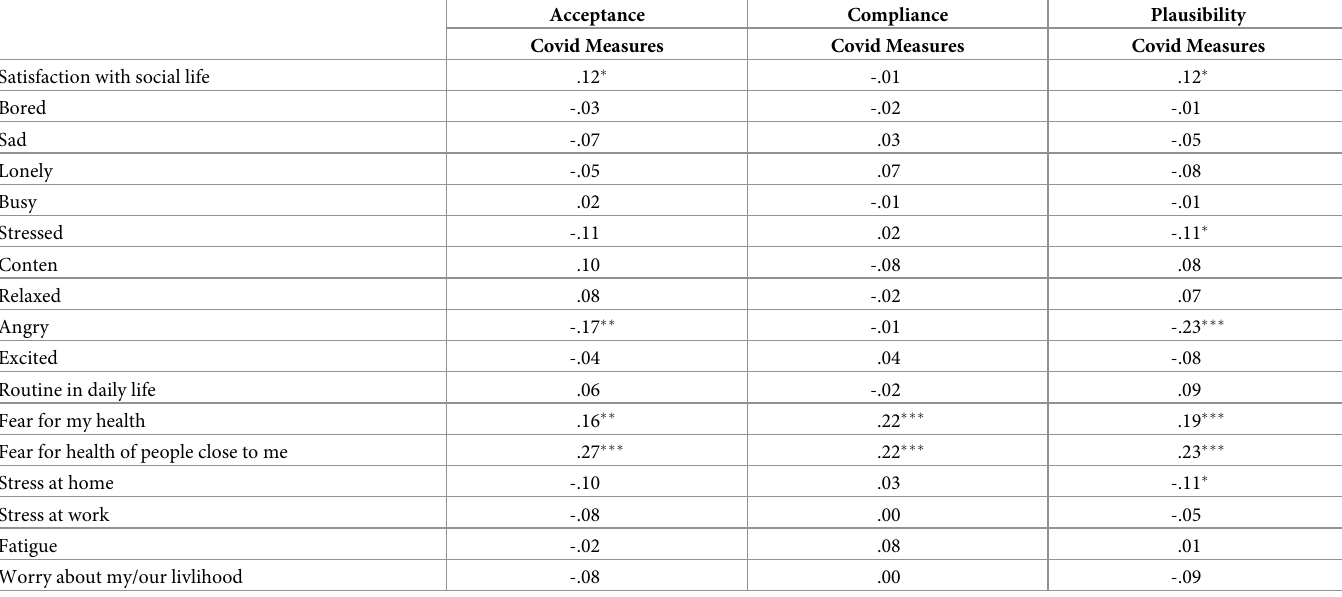
Table 3. Pearson correlation coefficients for the acceptance of, compliance with, and subjective plausibility of COVID-19 countermeasures with measures of emo- tion (9 variables) and routine/stress/worries (7 variables) across all 500